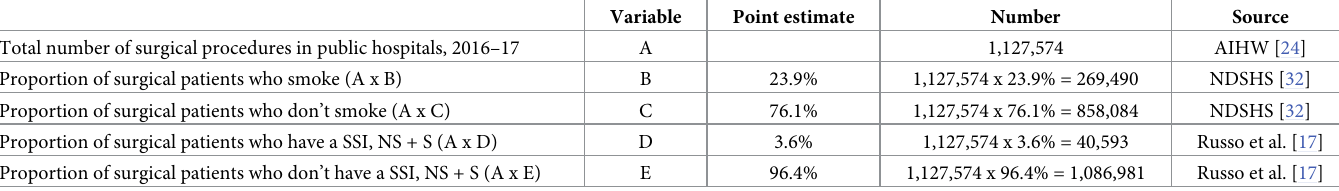
Table 1. Estimated annual expected number of surgical site infections in Australian public